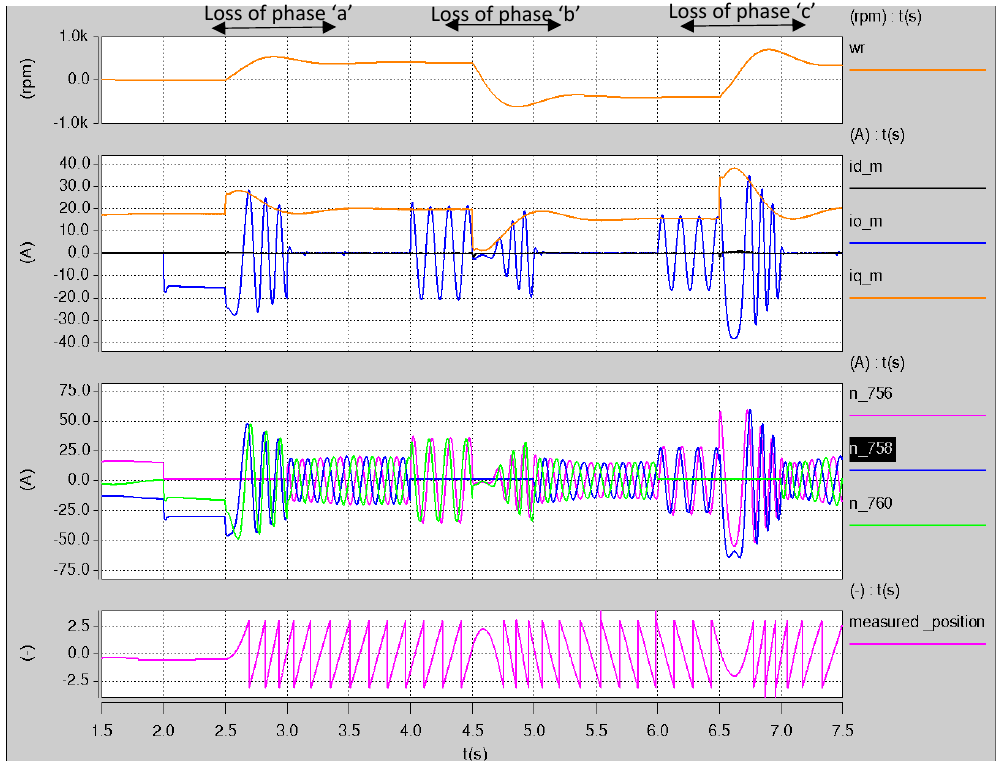
Figure 13. Fully encoderless speed steps between 500 and − 500 rpm under different operating conditions.